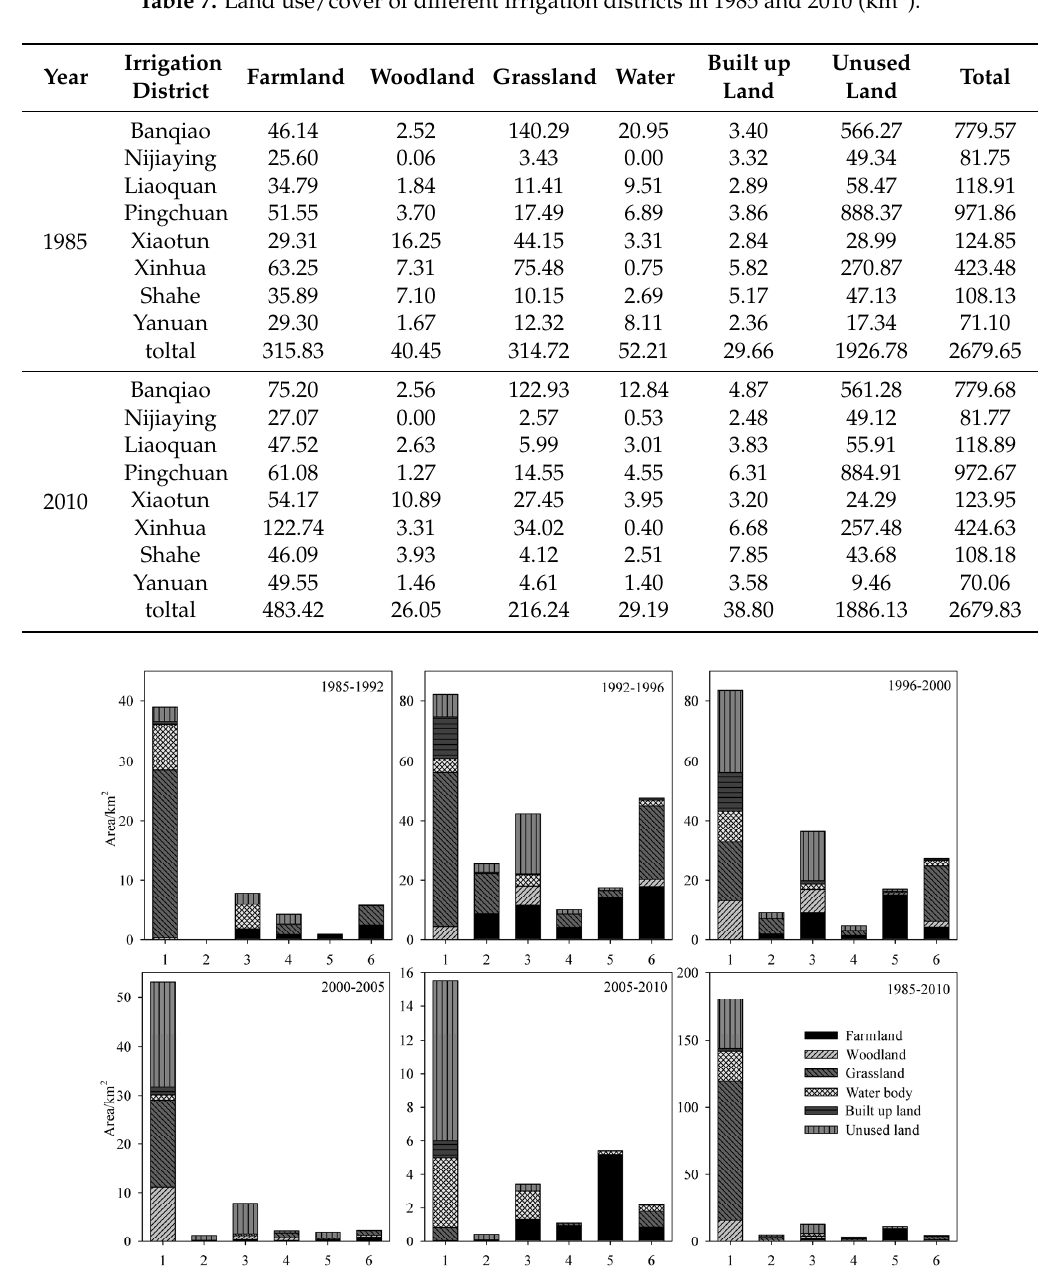
Figure 5. The transition area among land use types from 1985 to 2010 in Linze County (1 farmland, 2 woodland, 3 grassland, 4 water body, 5 built up land, 6 unused land. The histogram shows the transition area of one land use type in a certain period from the other land use types.).